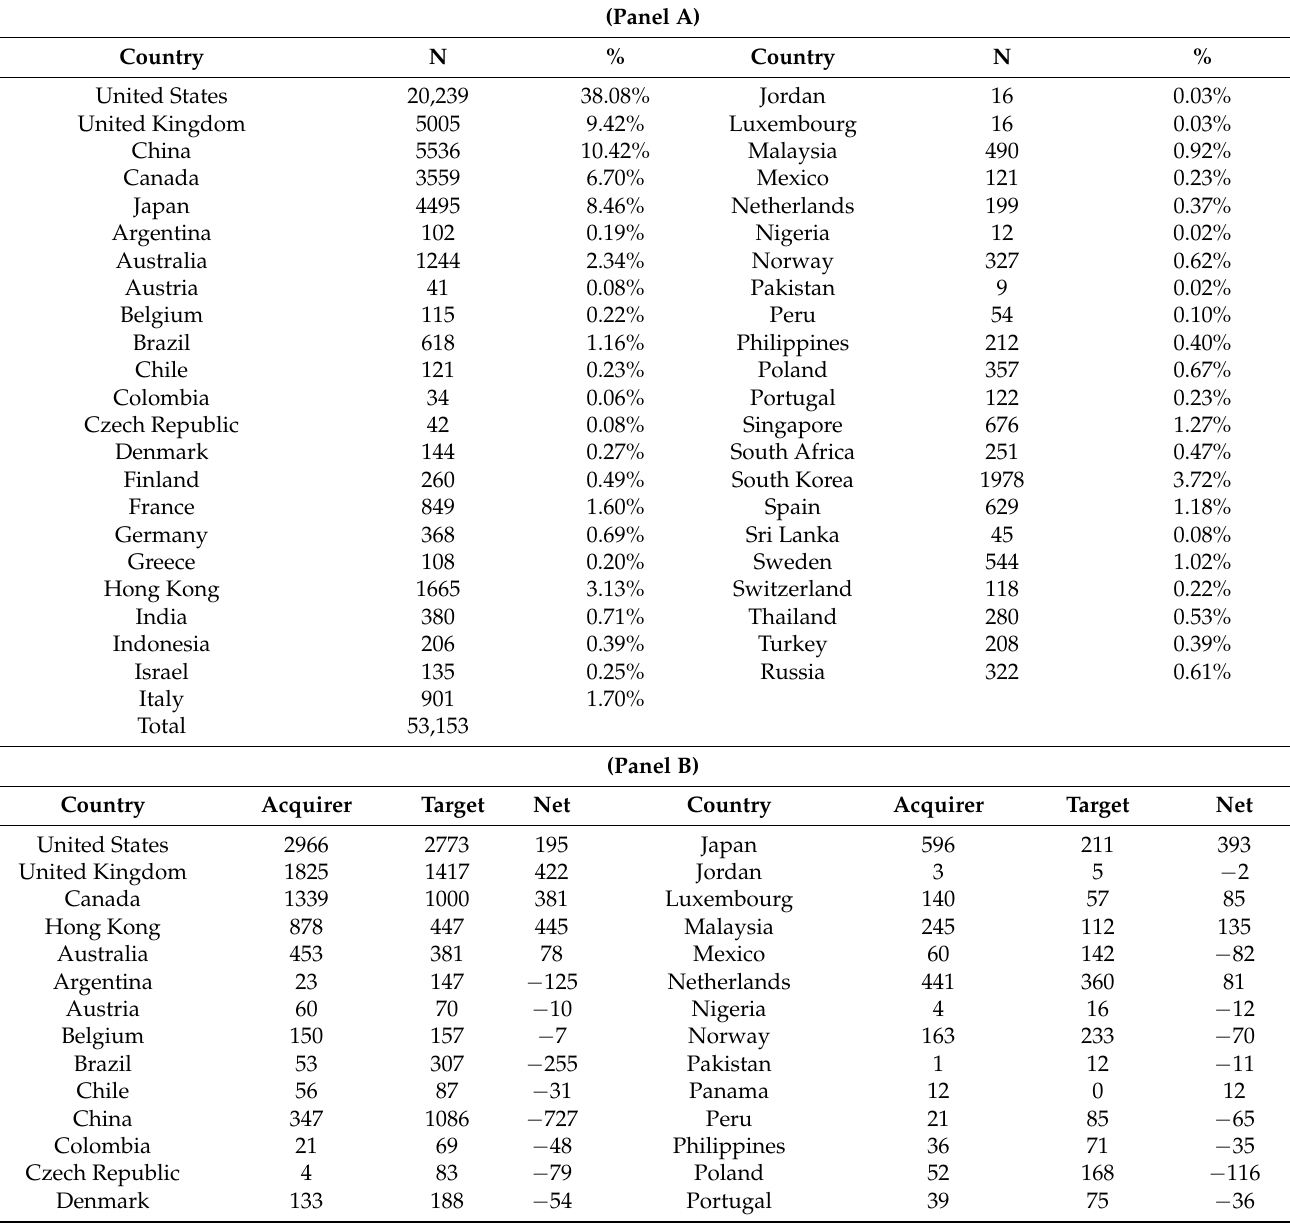
Table 1. ( Panel A ) Data on international mergers and acquisitions sorted by country name. The first five rows (in bold) show the five most active M&A markets by domestic deal volume. N is the number of announced deals in that country and % is the proportion of deals as a percentage of the total number of domestic deals in the sample. ( Panel B ) Data on cross-border mergers and acquisitions sorted by country name. The first five rows (in bold) show the top five most active cross-border M&A markets by volume. Acquirer is the number of deals in which the acquirer is domiciled in that country. Target is the number of deals in which the target is domiciled in that country. Net is the difference between Acquirer and Target . ( Panel C ) Data on the top five industries engaged in M&A deals across the full sample. Before is the mean number of deals per year where the acquiror or target was in that industry (indicated by a 4-digit SIC code) before social media became popular. After is the mean number of deals per year where the acquiror or target was in that industry after social media became popular. Diff is the difference between Before and After . (Panel